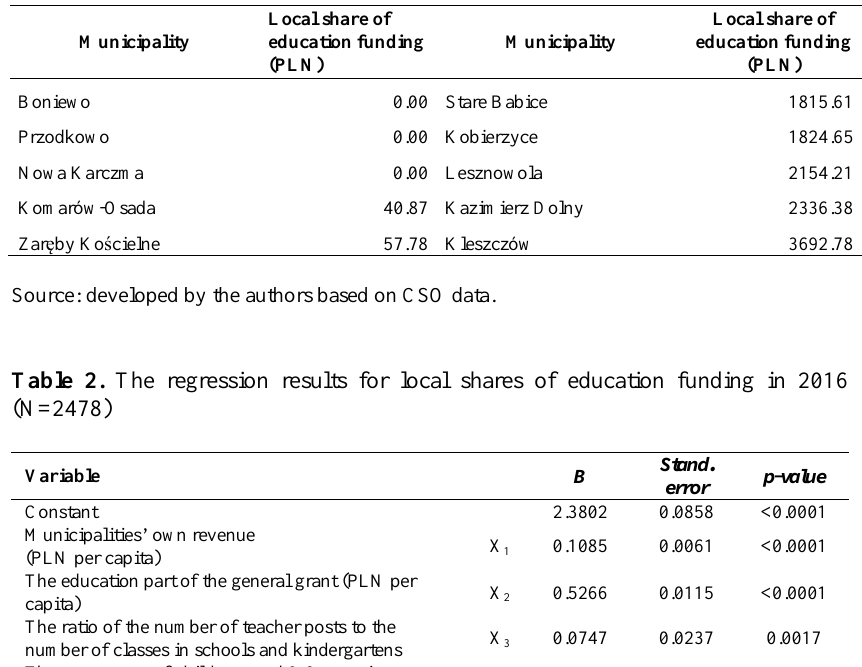
Table 1. Municipalities with the highest and lowest levels of local share of